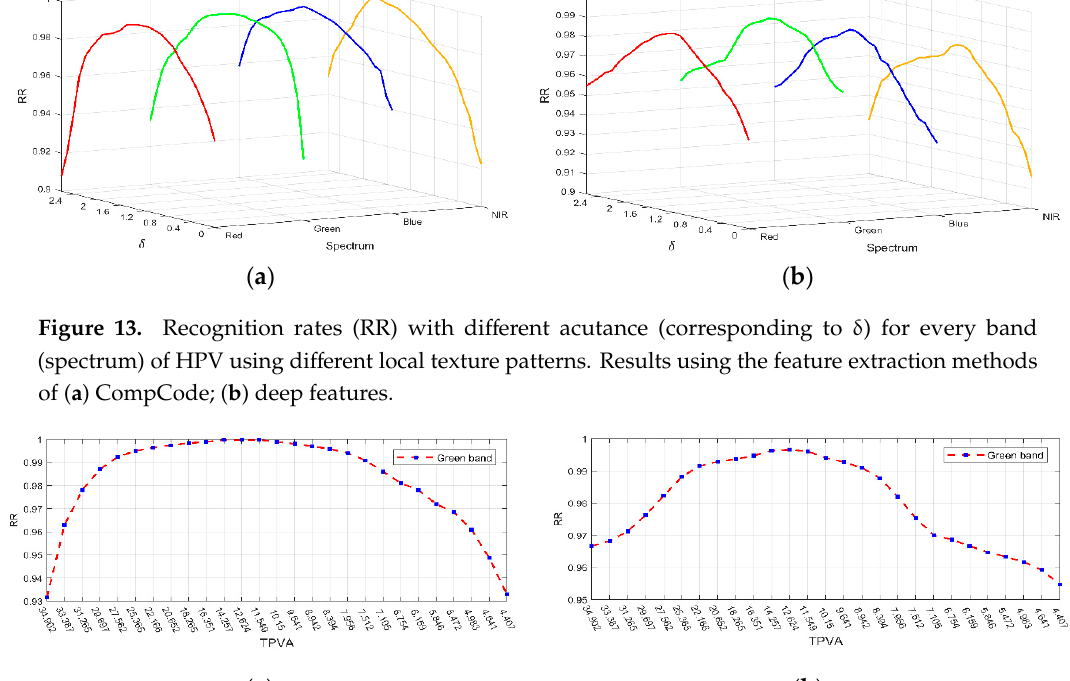
Figure 14. Recognition rates (RR) with different acutance TPVA on the green band of HPV with different local texture patterns. Results using the feature extraction methods of ( a ) CompCode; ( b ) deep features.